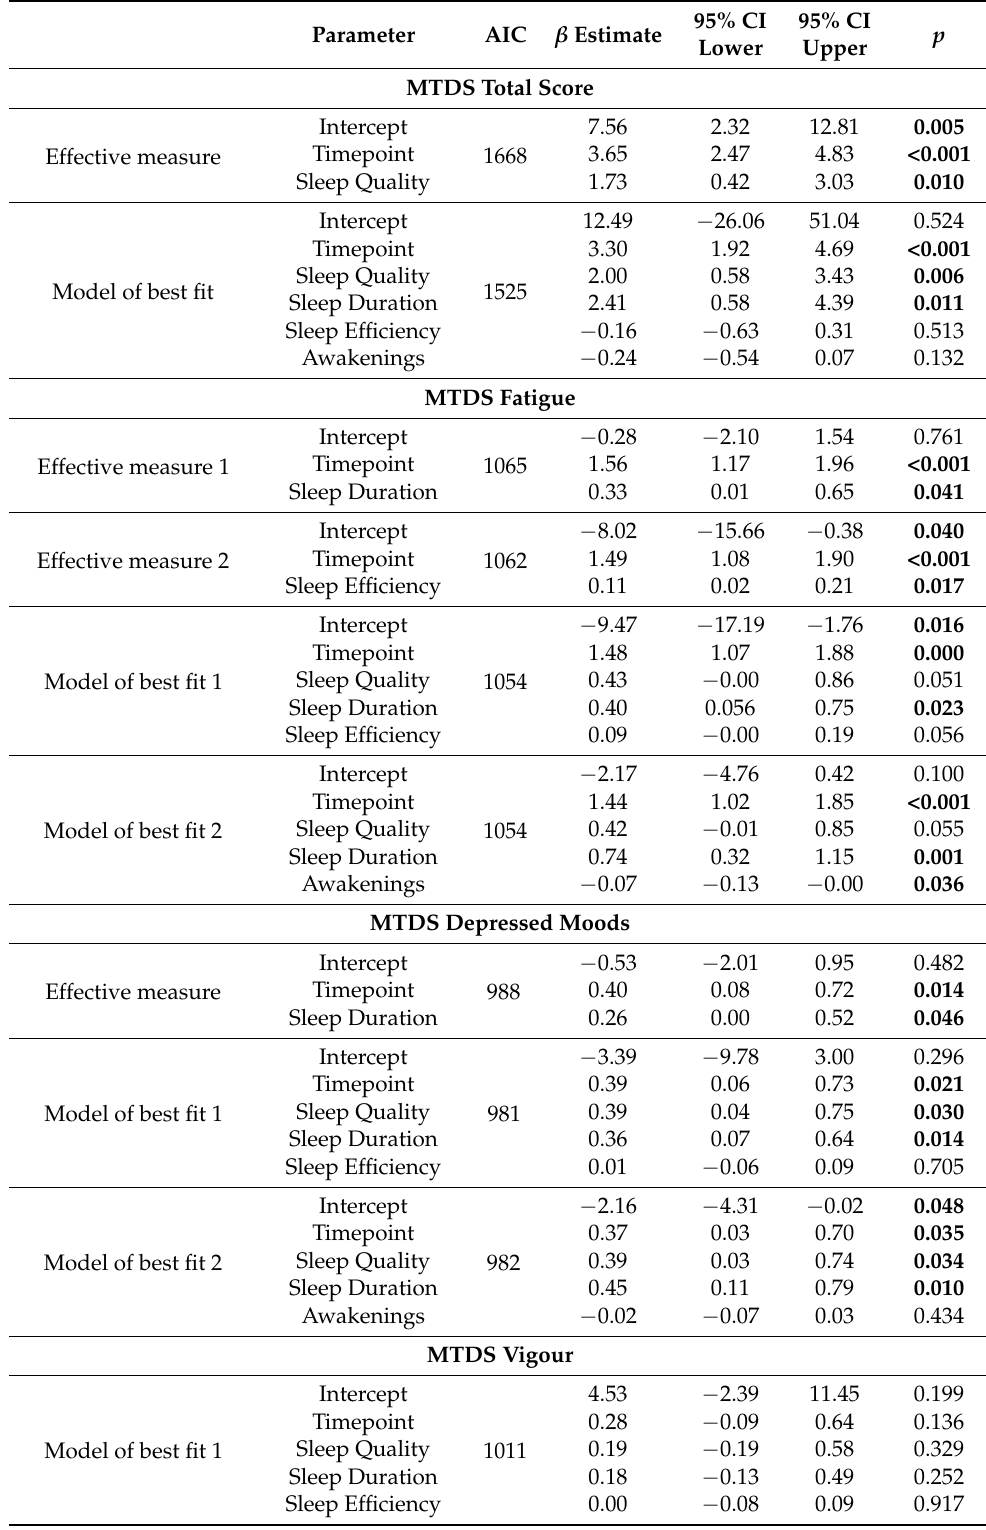
Table 2. Parameters of multi-level linear models of best fit, and significant single measure relation- ships for sleep quality, sleep duration, sleep efficiency and awakenings with